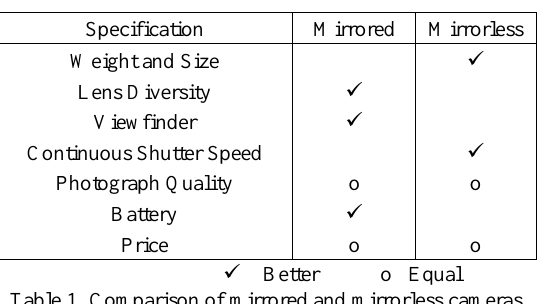
Figure 3. Study area